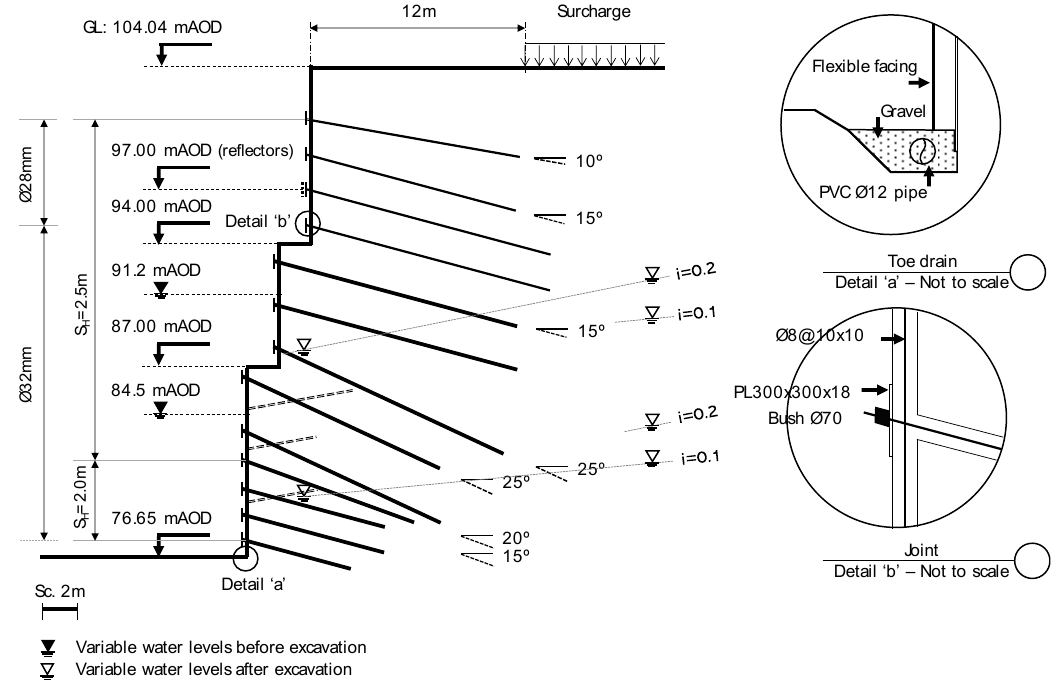
Figure 1. Cross-section diagram of the benchmark soil nailed system and adjoining features: S H is horizontal spacing, GL is ground level, PL is short for plate, mAOD is metres above ordnance datum, and Ø is diameter.